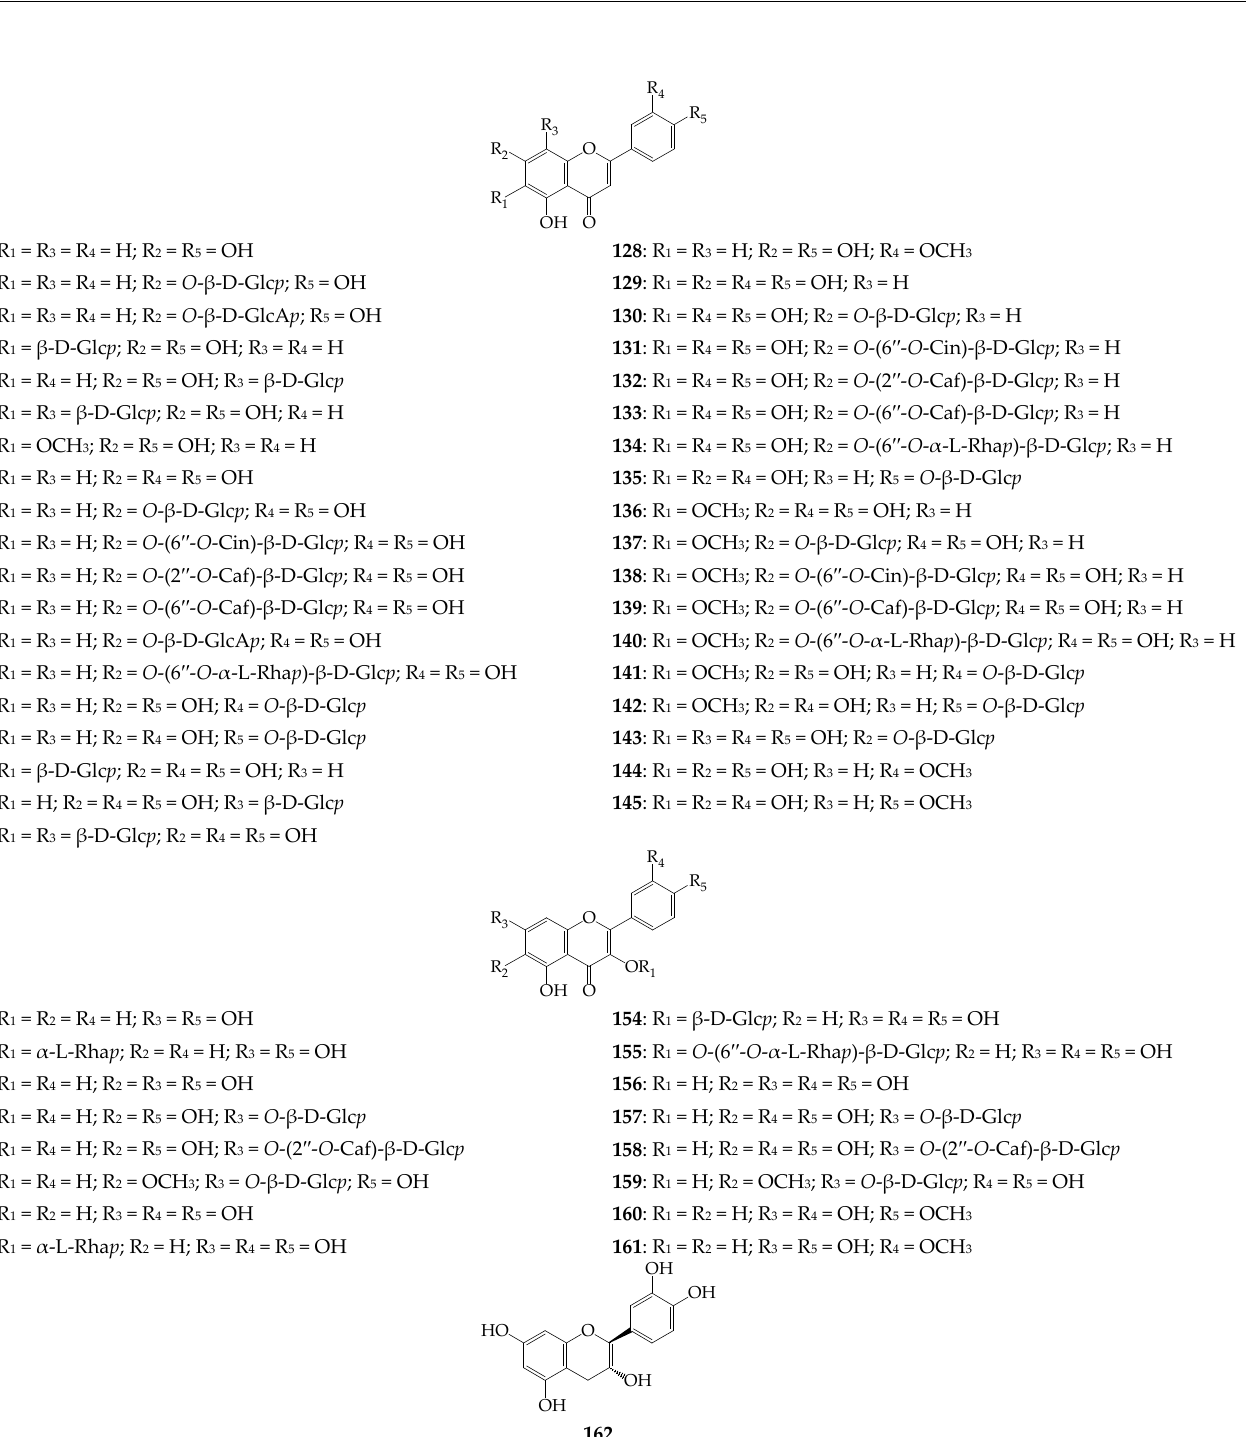
Figure 6 . Flavonoids 109 – 162 . Caf–caffeoyl; Cin– cinnamoyl; β -D-Glc p – β -D- glucopyranose; β